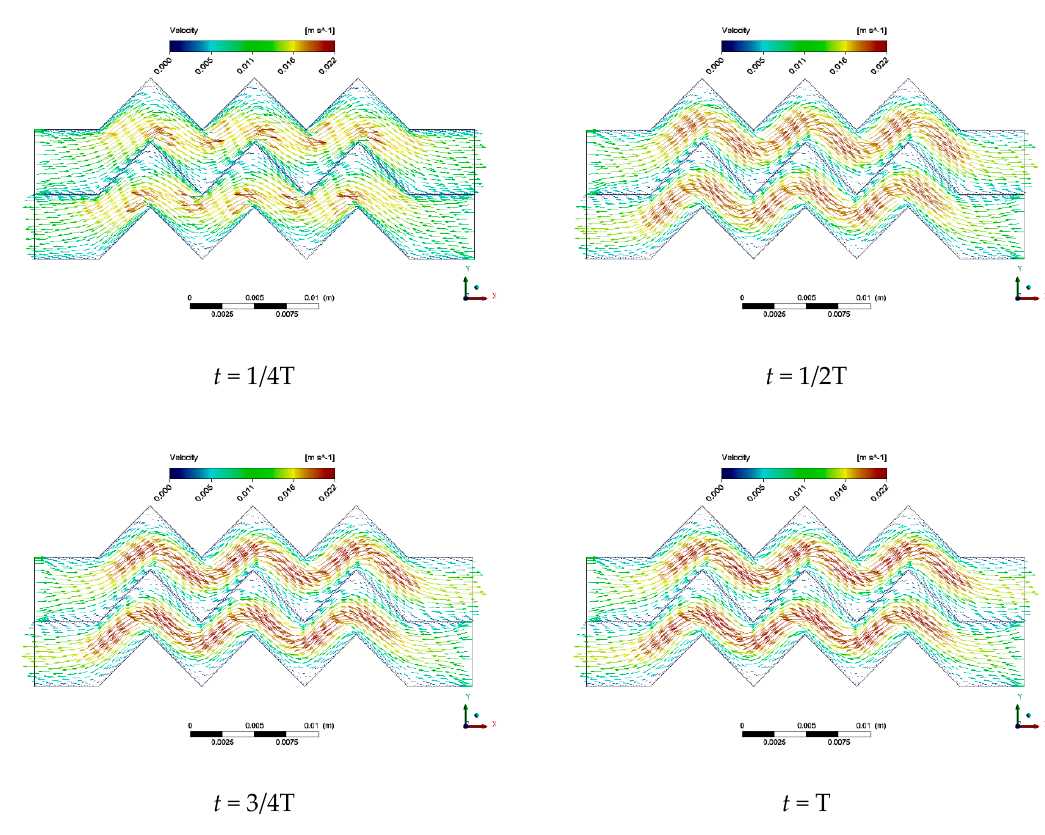
Figure 7. Velocity vectors distribution at different time.